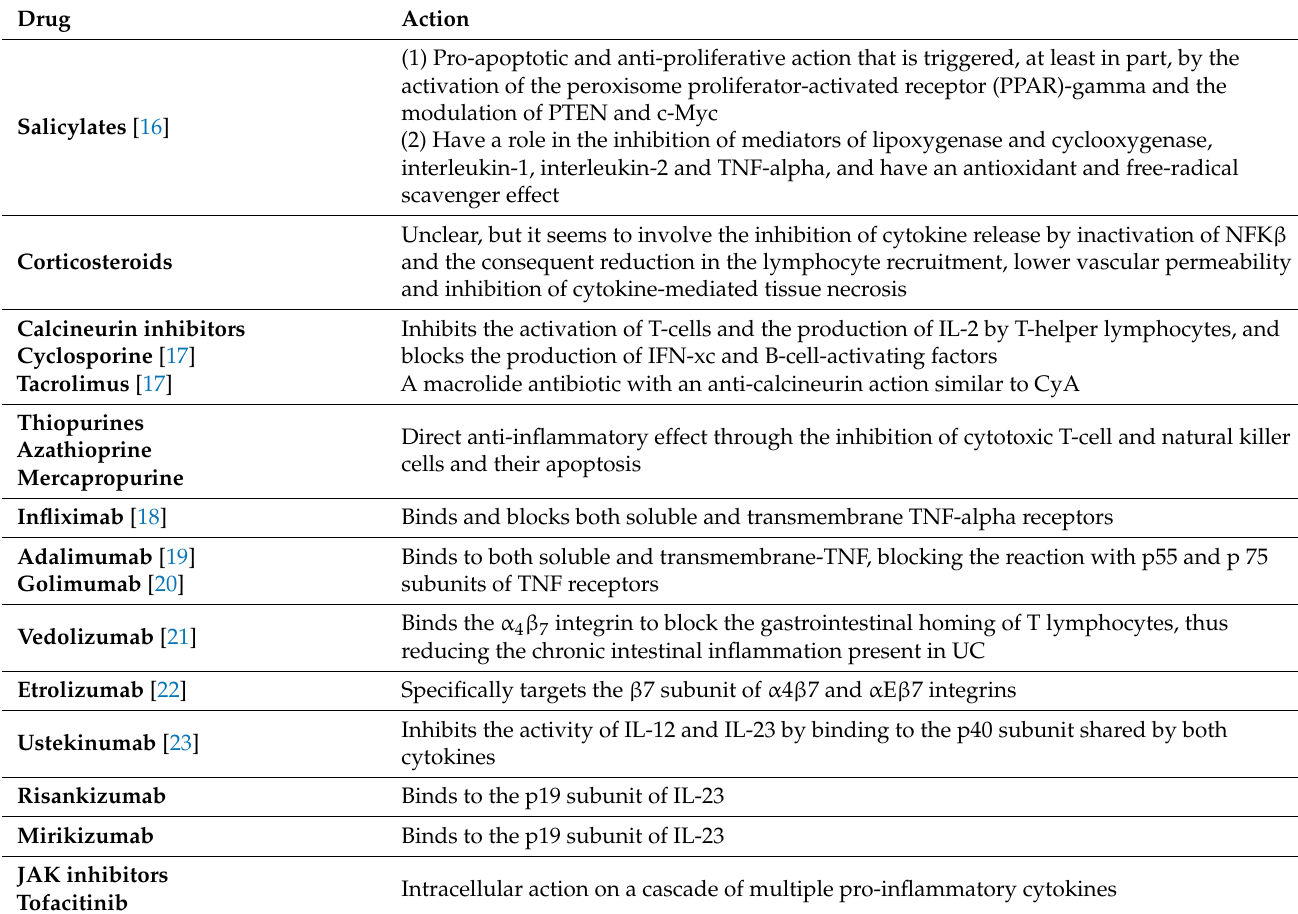
Table 2. Mechanism of action of Ulcerative Colitis (UC)